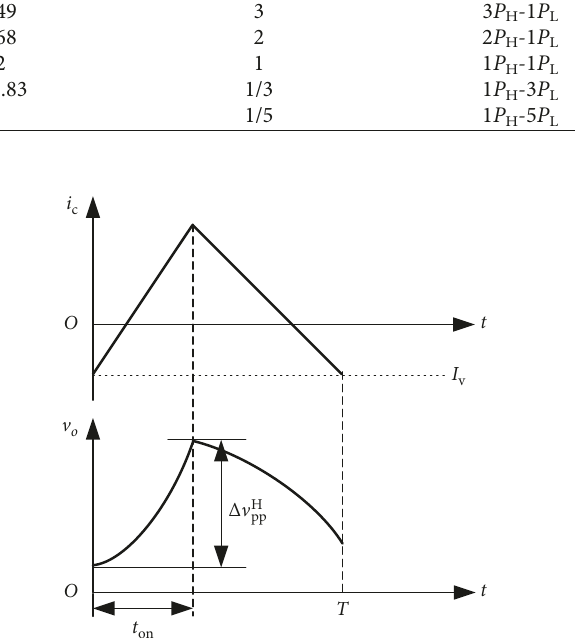
Figure 5: Capacitor current and output voltage of the DCPT- controlled buck converter.